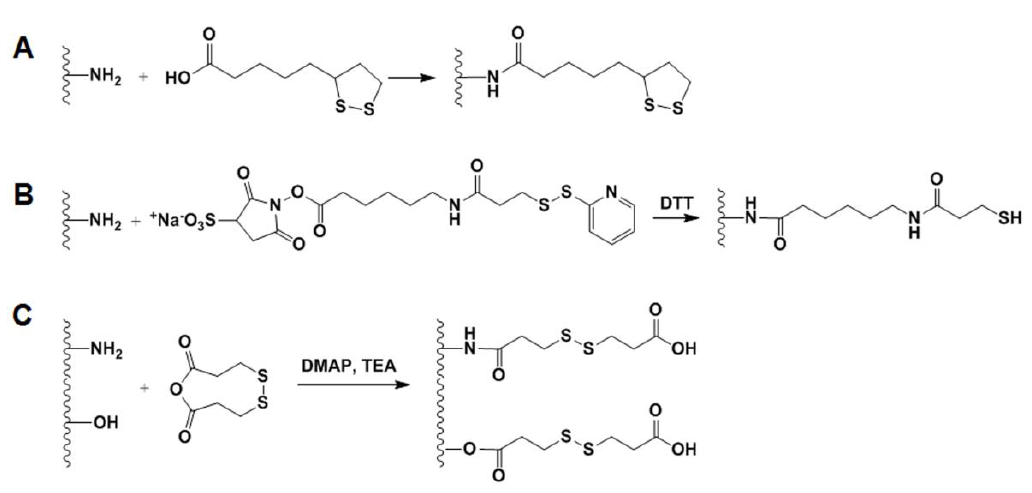
Figure 4. ( A ) Synthetic schemes for preparation of GC-lipoic acid (GC-LA). Due to hydrophobic property of LA, GC-LA can encapsulate hydrophobic drug and further core-crosslinking using DTT. ( B ) Thiolated GC (tGC) derivative was prepared by conjugating GC with Sulfo-LC-SPDP, followed by treating DTT. The tGC was further cross-linked to various poly-siRNA with dithiol end groups. ( C ) To synthesize bioreducible PEI-GC as a gene delivery carrier, DTDPA was conjugated to GC through amide or ester bonds in the presence of DMAP and TEA.